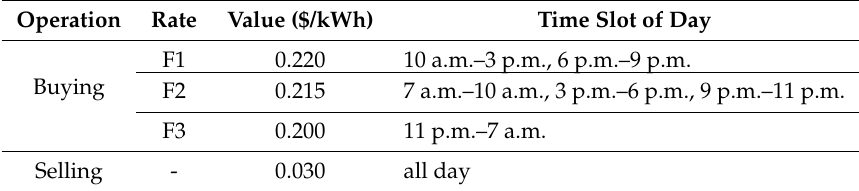
Table 3. Electricity prices in different time of the day, as defined in